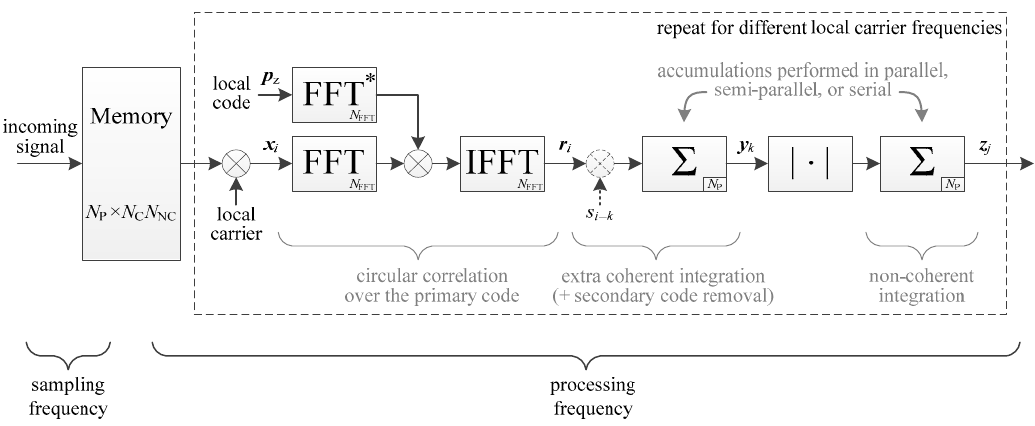
Figure 1. Overview of the considered parallel code search with long integration. Dashed blocks are optional.